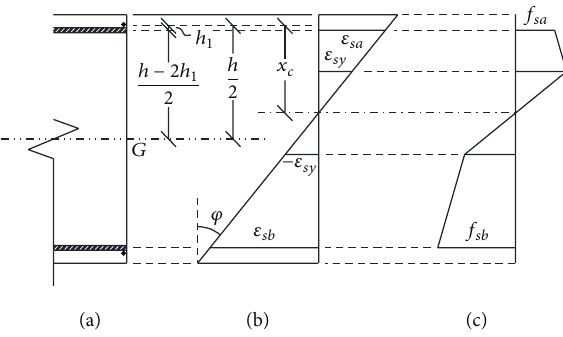
Figure 4: Strain and stress states of principal reinforcement of